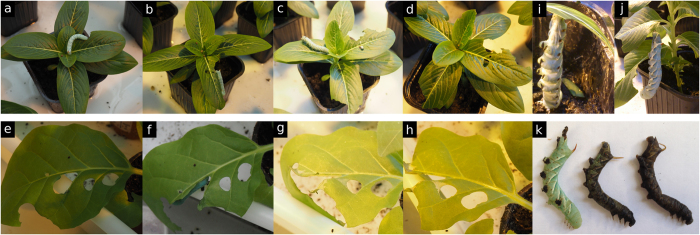
Manduca sexta larvae feeding of C. roseus (a–d) and N. tabacum (e–h) leaves. Pictures were taken 2 h (a,e), 24 h (b,f), 48 h (c,g) and 72 h (d,h) after placing caterpillars on leaves. (i,j) Typical morphologic alteration of caterpillars feeding on C. roseus, hanging by their softened end. k, browning phenotypes usually obtained after 72 h of feeding.